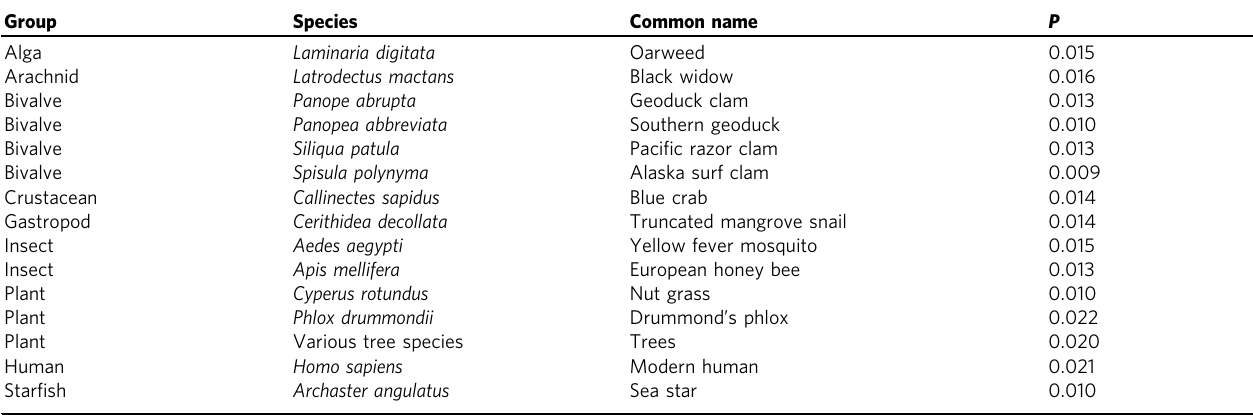
Table 1 Survival to maximum age across various species. Group